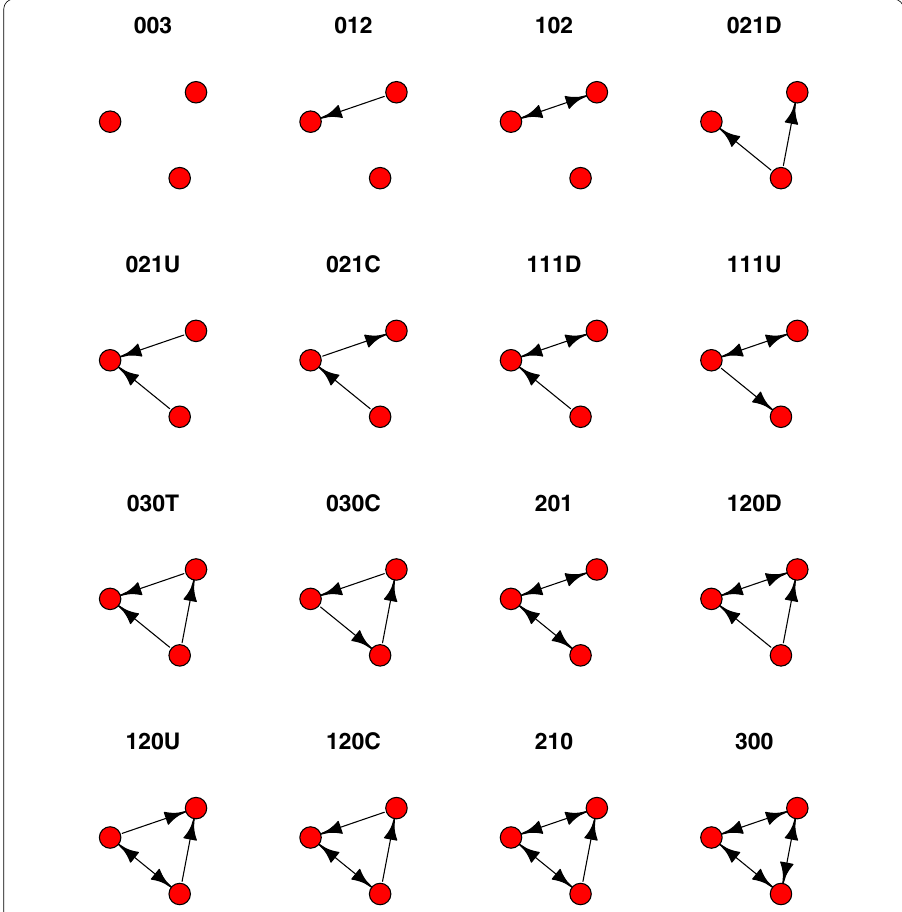
Fig. 1 Triad census classes labeled with the MAN (mutual, asymmetric, null) dyad census naming convention. When the dyad census does not uniquely identify a triad, a letter designating “up”, “down”, “transitive”, or “cyclic” is